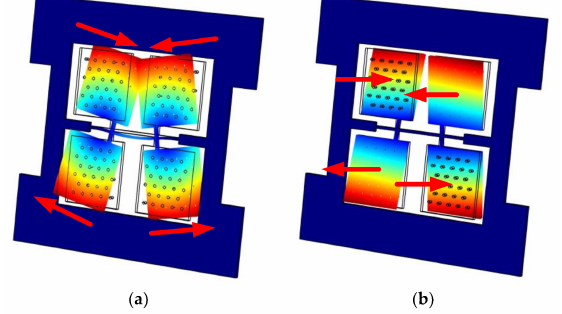
Figure 1. The operation modes of the butterfly vibratory gyroscope (BFVG) by COMSOL (5.2, Stockholm, Sweden). ( a ) The driving mode; ( b ) The sensing